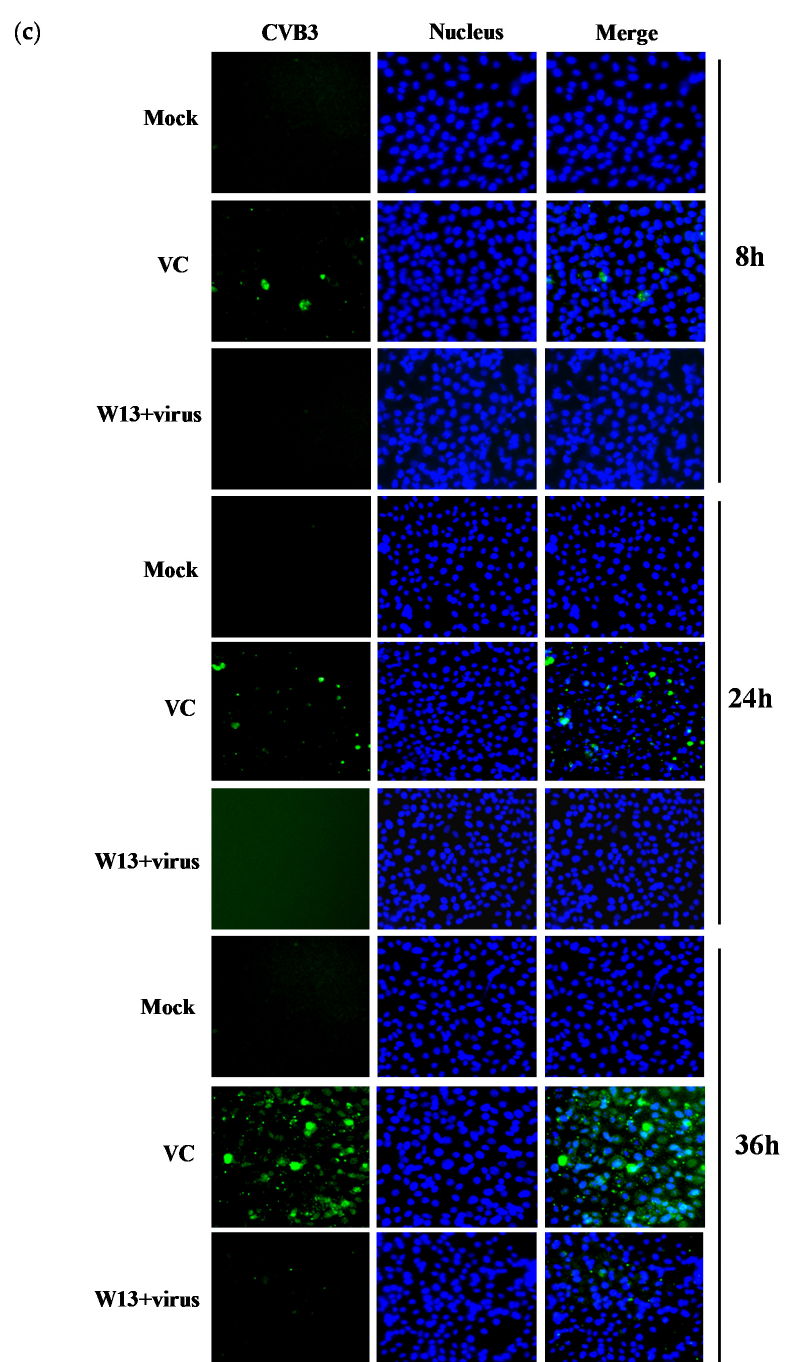
Figure 5. Effect of W13 on CVB3 replication in Hep-2 cells. Hep-2 cells infected with 100 TCID 50 CVB3 were incubated in the absence or presence of 160 μ M W13 and harvested at the indicated times post-infection. ( a ) Progeny virus yields were determined. ( b ) Viral RNA levels were measured by analysis of total RNA. GAPDH was amplified and the resulting data was used for normalization. Values represent the means ± SDs of three independent experiments. * p < 0.05; ** p < 0.01, compared with the virus control group. ( c ) CVB3 protein levels were determined by indirect immunofluorescence, using the mouse anti-coxsackie virus B3 monoclonal antibody, MAB948, and an alexa-fluor-488-conjugated a ffi niPure goat anti-mouse IgG (H + L), after incubation with W13 for 24 h. Nuclei were stained with DAPI and green foci indicate the presence of CVB3